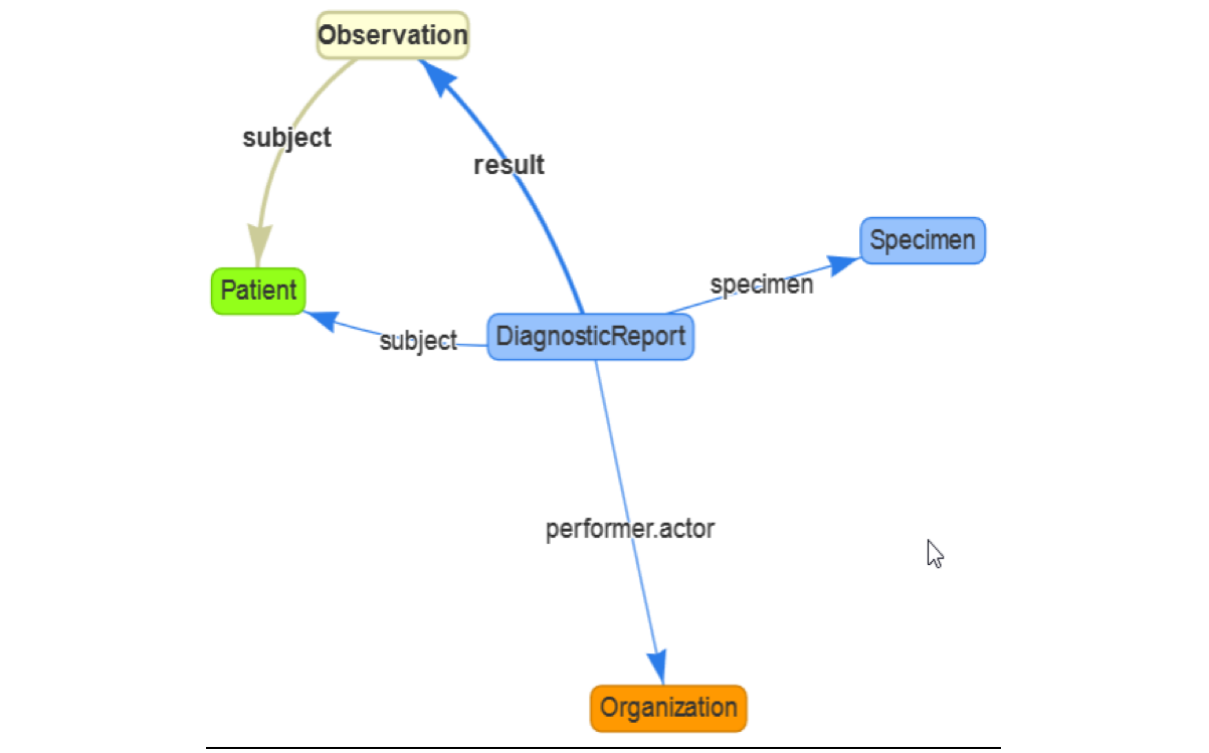
Figure 5. clinFHIR diagram with the resources and references. This graph shows the resources and element in the source resource that represents the